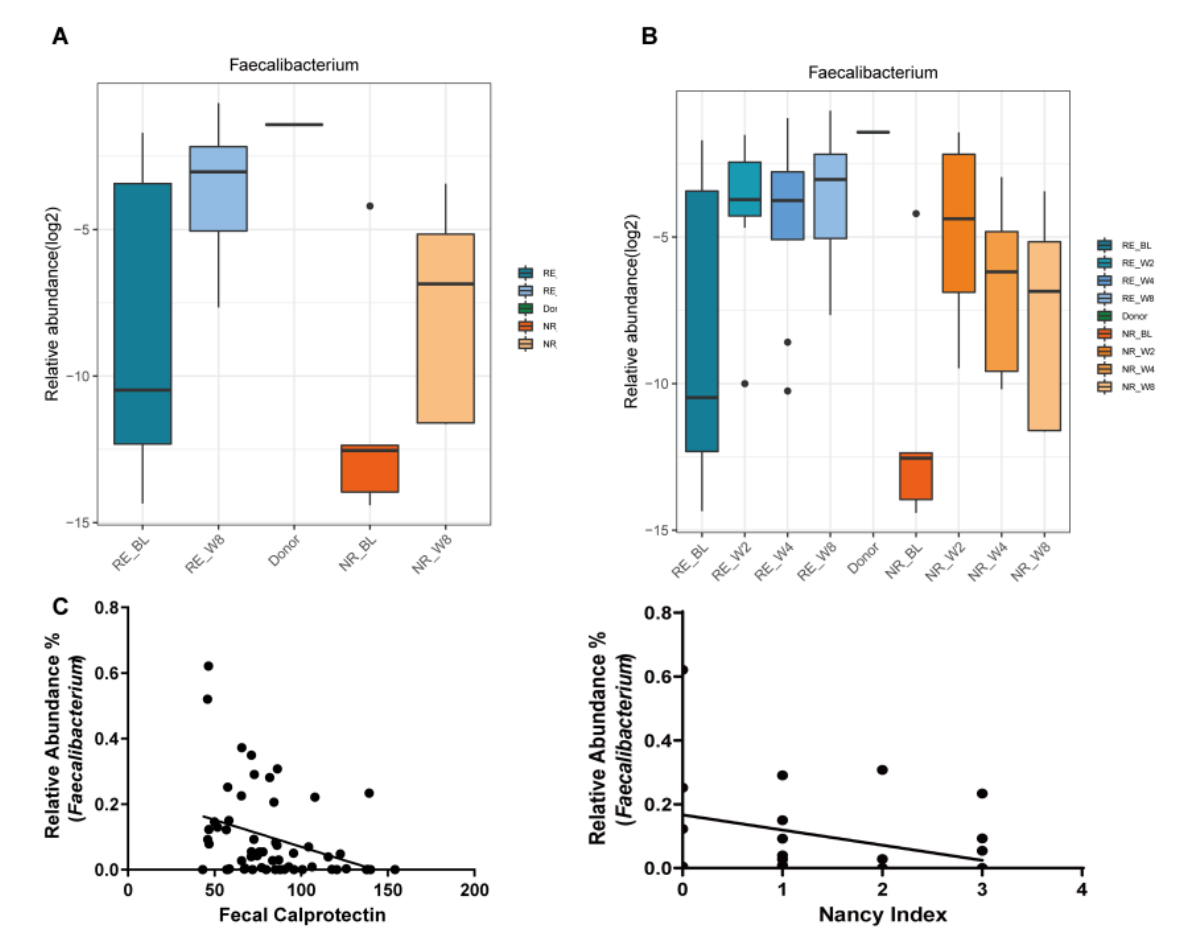
Figure 5. Faecalibacterium colonization was associated with ulcerative colitis (UC) remission with FMT. ( A ) The relative abundance of Faecalibacterium in responders (RE) and non-responders (NR) groups at baseline (BL) and 8 weeks after FMT (W8). ( B ) The relative abundance of Faecalibacterium in multi-time points after FMT. ( C ) Correlation of relative abundance of Faecalibacterium with fecal calprotectin (r = − 0.382, p = 0.003) and Nancy index (r = − 0.497, p = 0.006).